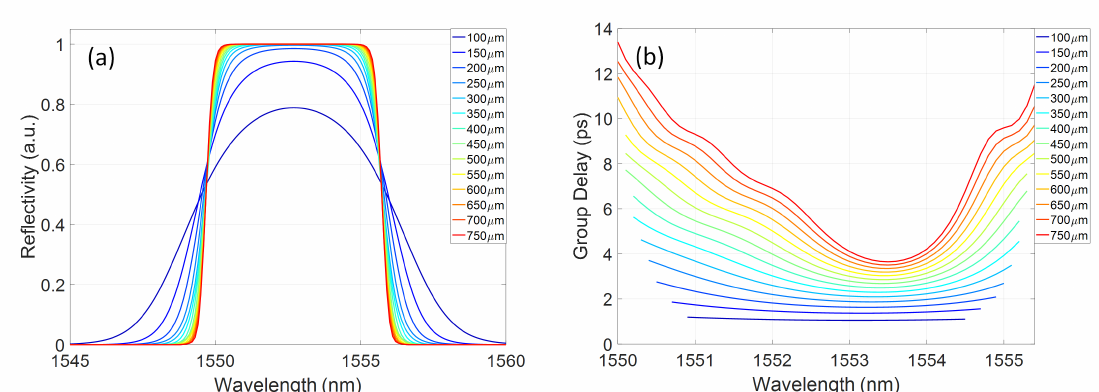
Figure 11. Simulated grating: ( a ) reflectivity; and ( b ) group delay spectra with grating length as a